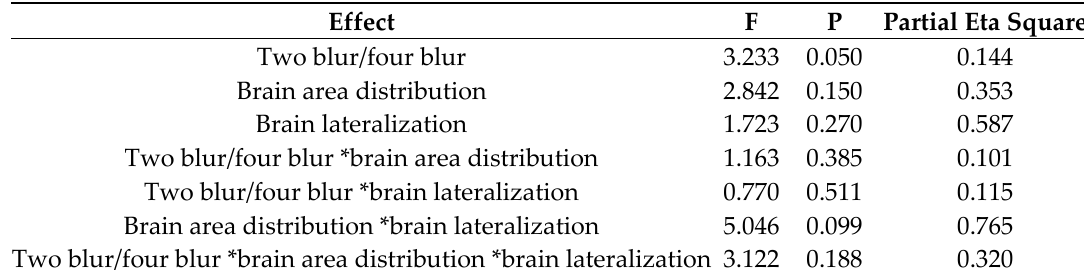
Table 5. The results of 200~400 ms in the control